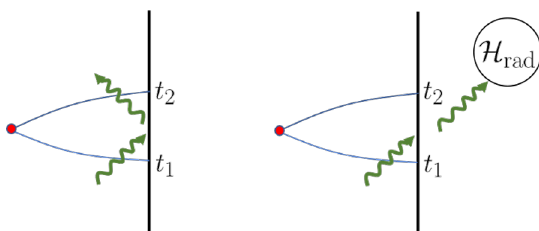
Figure 1. With re(cid:13)ecting boundary conditions, outgoing modes in a surface ending on the bound- ary at time t 1 may become ingoing modes on a surface ending at time t 2 , but the same degrees of freedom will always be contained in each surface. The bulk entropy cannot depend on the boundary time. In contrast, with absorbing boundary conditions, outgoing modes at time t 1 may escape the bulk in the reservoir H rad by time t 2 , and so no longer be contained in a surface ending at time t 2 . The bulk entropy, and hence the notion of quantum extremality, depends on the boundary